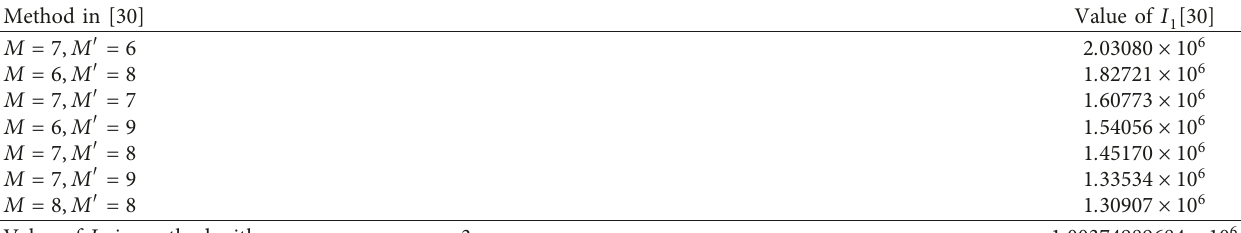
Table 2: The value of I